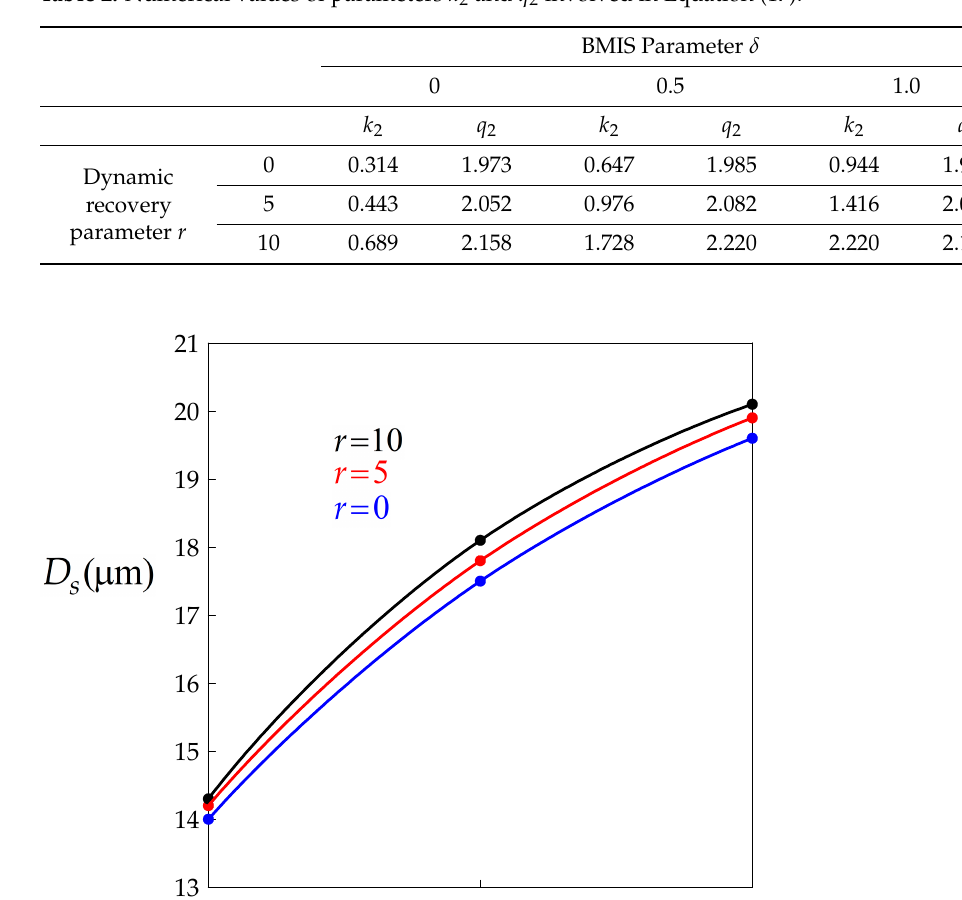
Table 2. Numerical values of parameters k 2 and q 2 involved in Equation (17).